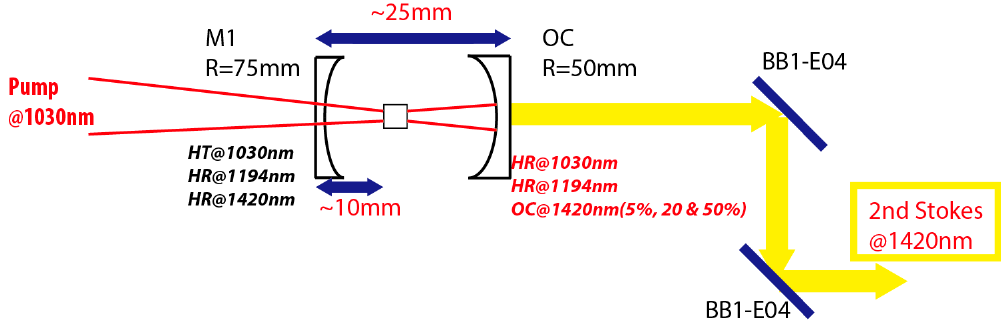
Figure 4. Experimental setup of the diamond Raman laser pumped by the Yb:YAG laser (HT: high transmission; HR: high reflection; OC: outup coupler).